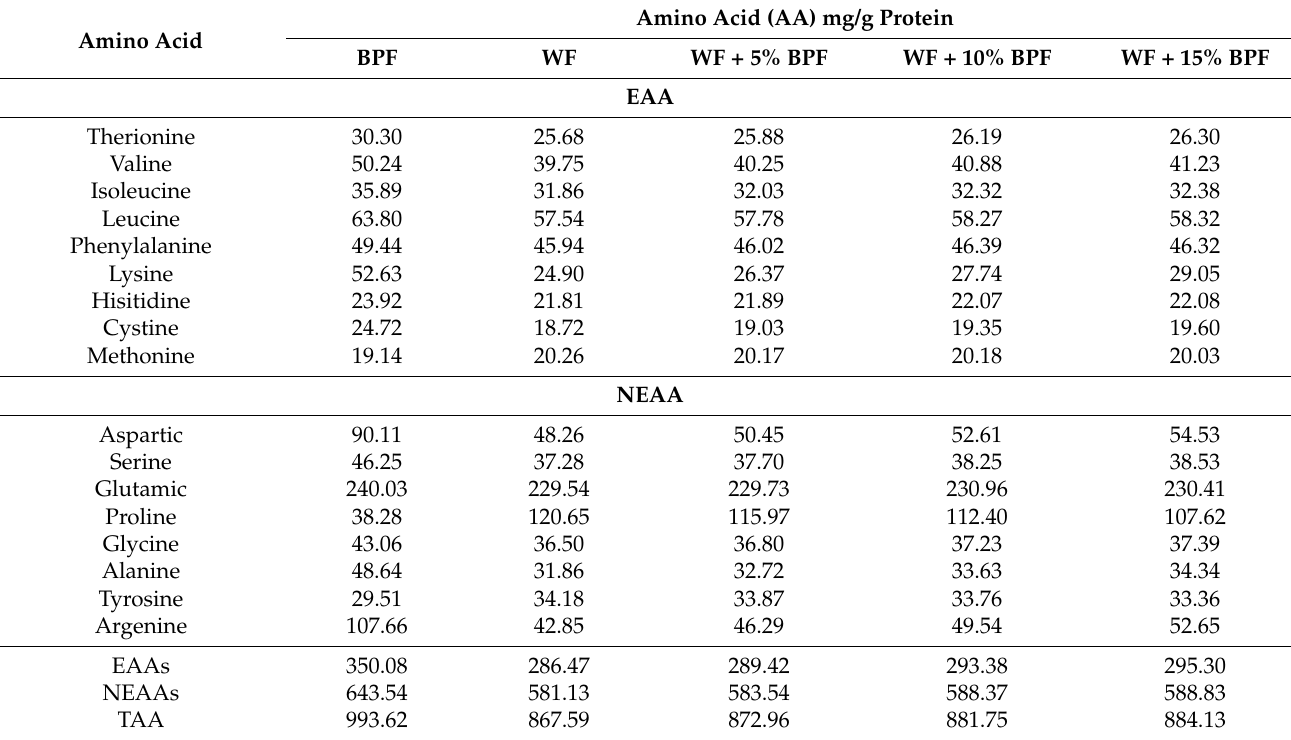
Table 5. Amino acid composition (mg g − 1 protein) of WF and different substituted WF with BPF ( A. digitate ). Amino